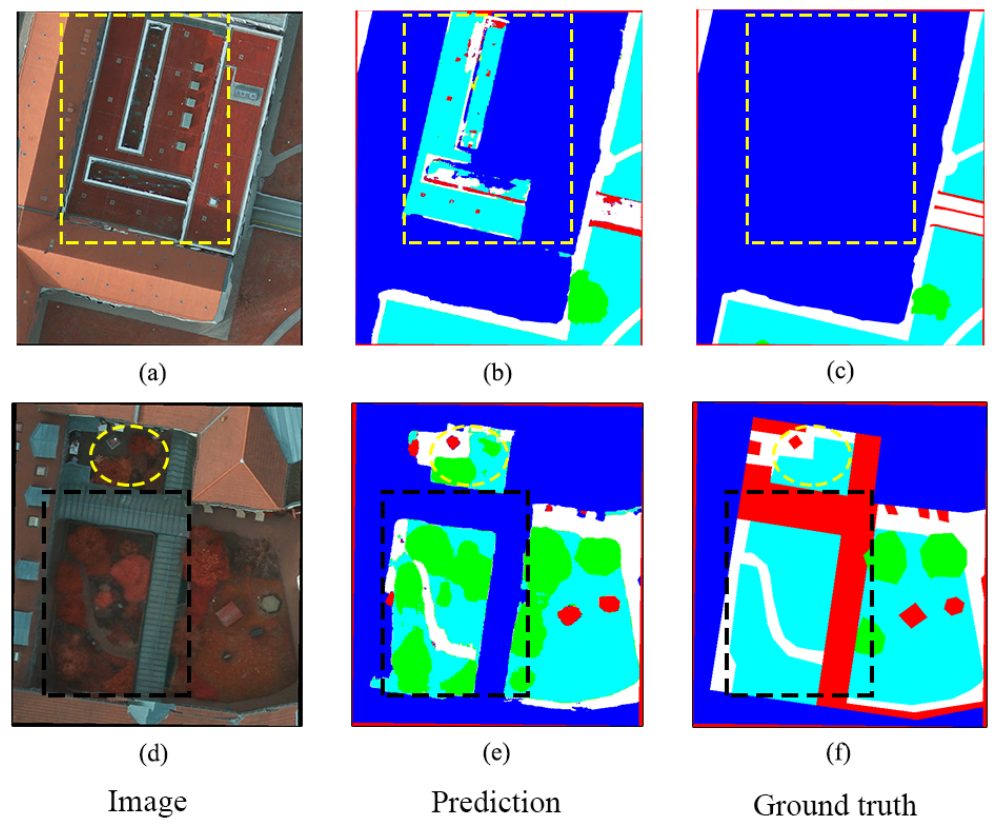
Figure 9. Some factors caused misclassification. ( a – c ) A special testing sample that lawn on building roof is classified as low vegetation class shown in ( b ), while the ground truth image ( c ) labels it as building. ( d – f ) The building and trees are incorrectly labeled as the background and low vegetation class shown in ( f ), while the ( e ) achieves a correct prediction result.